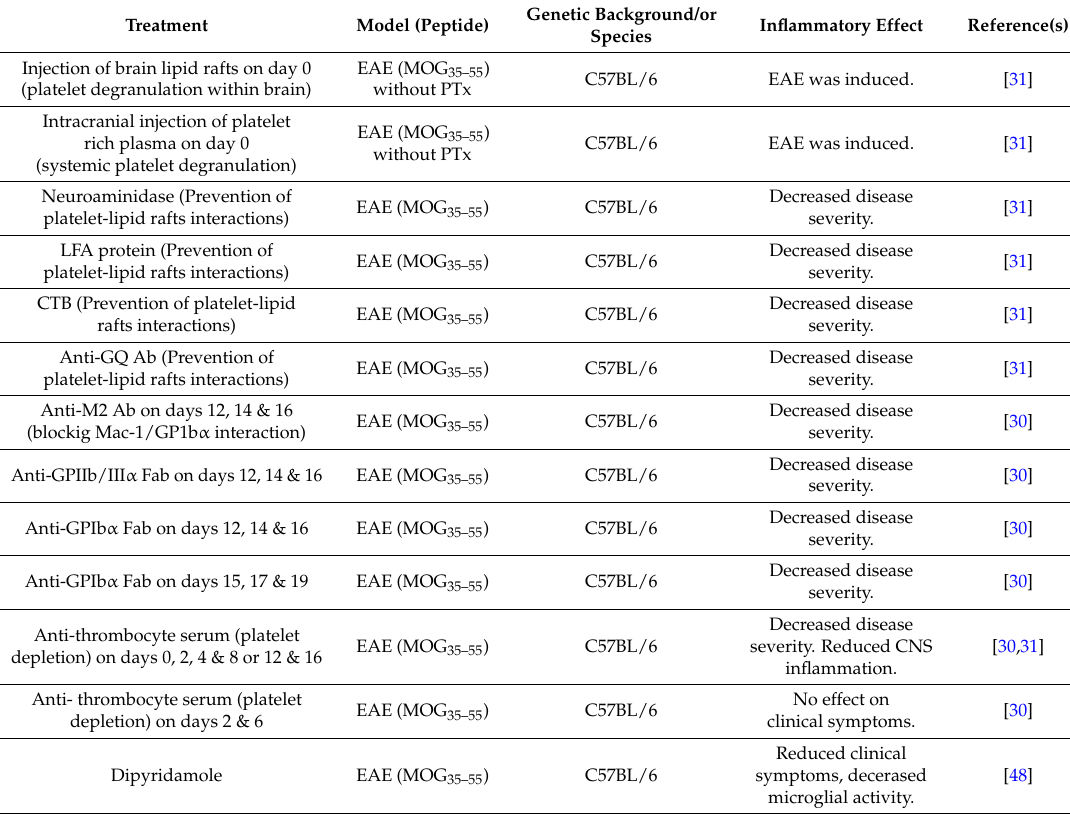
Table 2. Studies of platelets, their receptors and molecules contributing to neurovascular inflammation using pharmacological substances/experimental manipulations. Model